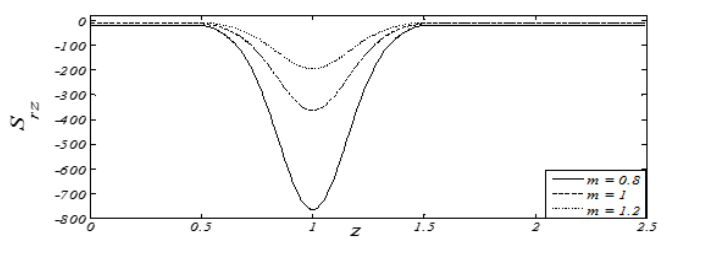
Fig. 9 Wall shear stress variation for F=1, L=1, a=0.2, b=0.4, δ